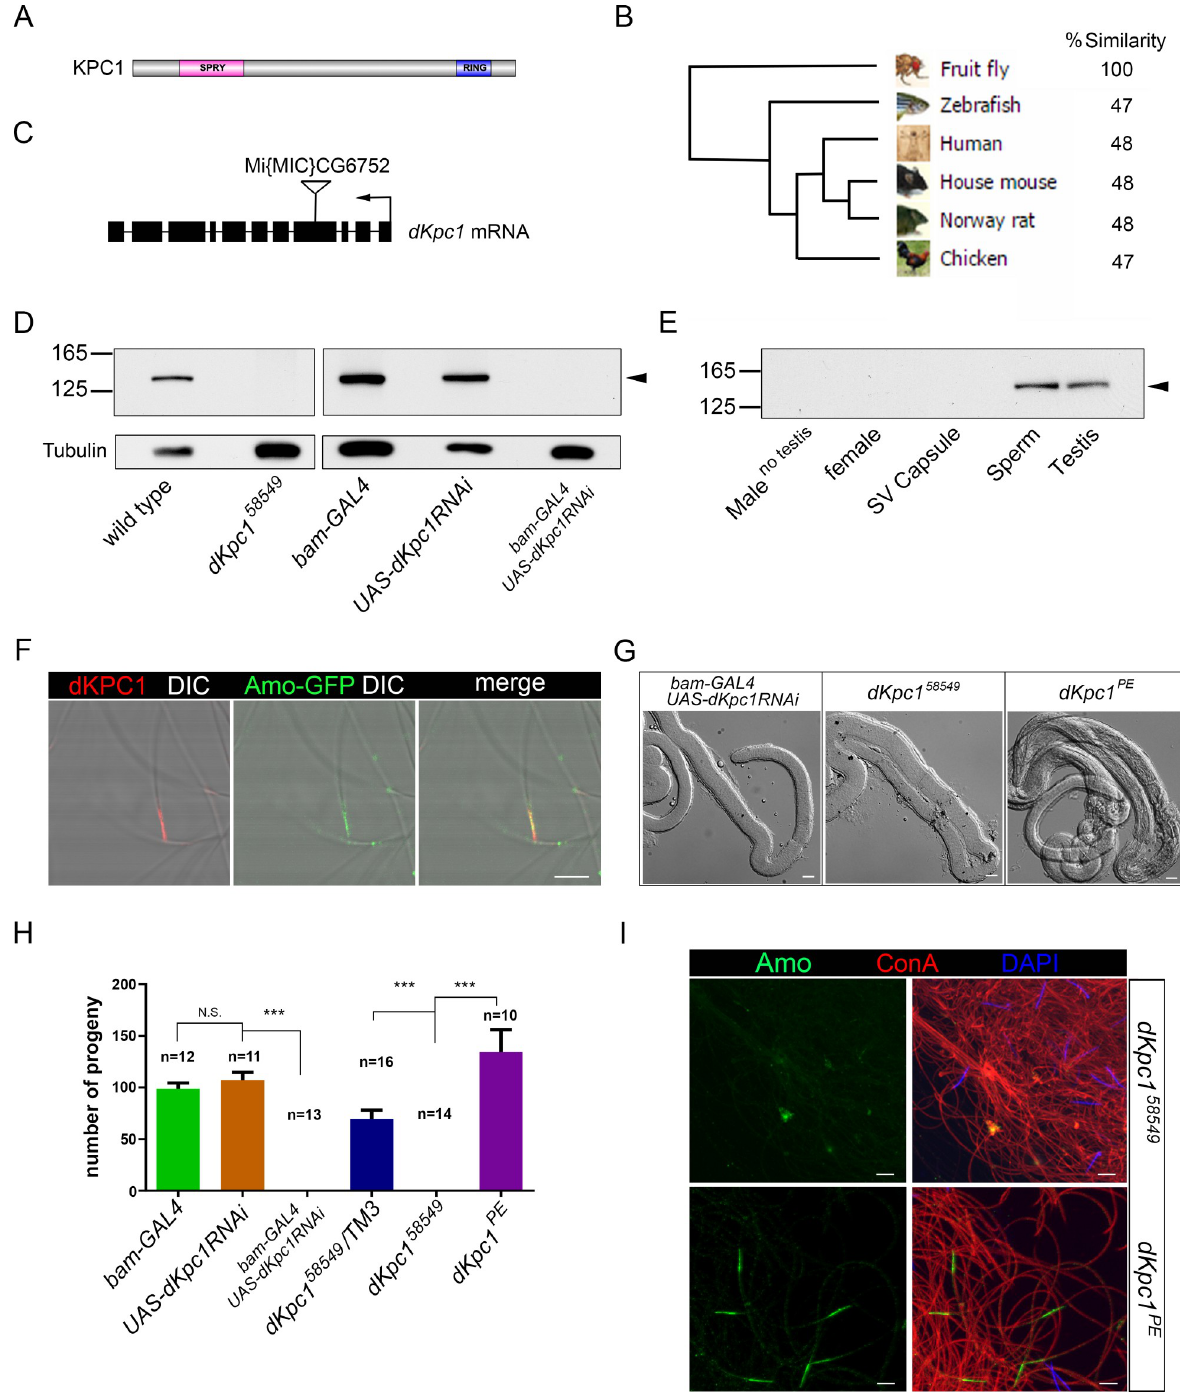
Fig 4. Drosophila Homolog of KPC1 (dKPC1) is required for sperm storage and Amo Localization. (A) Domain structure of dKPC1 showing an N-terminal SPRY domain and a C-terminal Ring-finger domain. dKPC1 has 1332 amino acids and is predicted to be ~151 kDa in size. (B) Phylogenetic tree demonstrates homology between dKPC1 and related proteins. (C) Map of the CG6752/ dKpc1 locus showing the MiMIC transposon insertion ( dKpc1 58549 ) in Exon 4. Black arrow indicates the direction of transcription. (D-E) Western blots probed with antisera to dKPC1. The antibody detects a single band of ~151 kDa, indicated by the arrowhead, in wild type testes and sperm. There is no dKPC1 detectable in testes dissected from dKpc1 58549 males, from males with RNAi mediated knock-down of dKpc1 , in females or in males lacking testes. (F) Amo-GFP sperm stained with antisera to dKPC1: red and to GFP: green. DIC and fluorescence images are merged showing that the two proteins partially co-